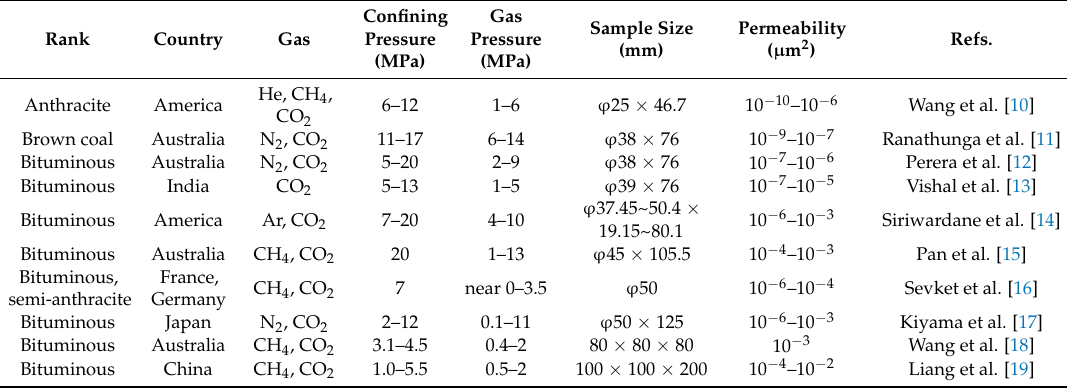
Table 1. Permeability of natural coal samples in the previous